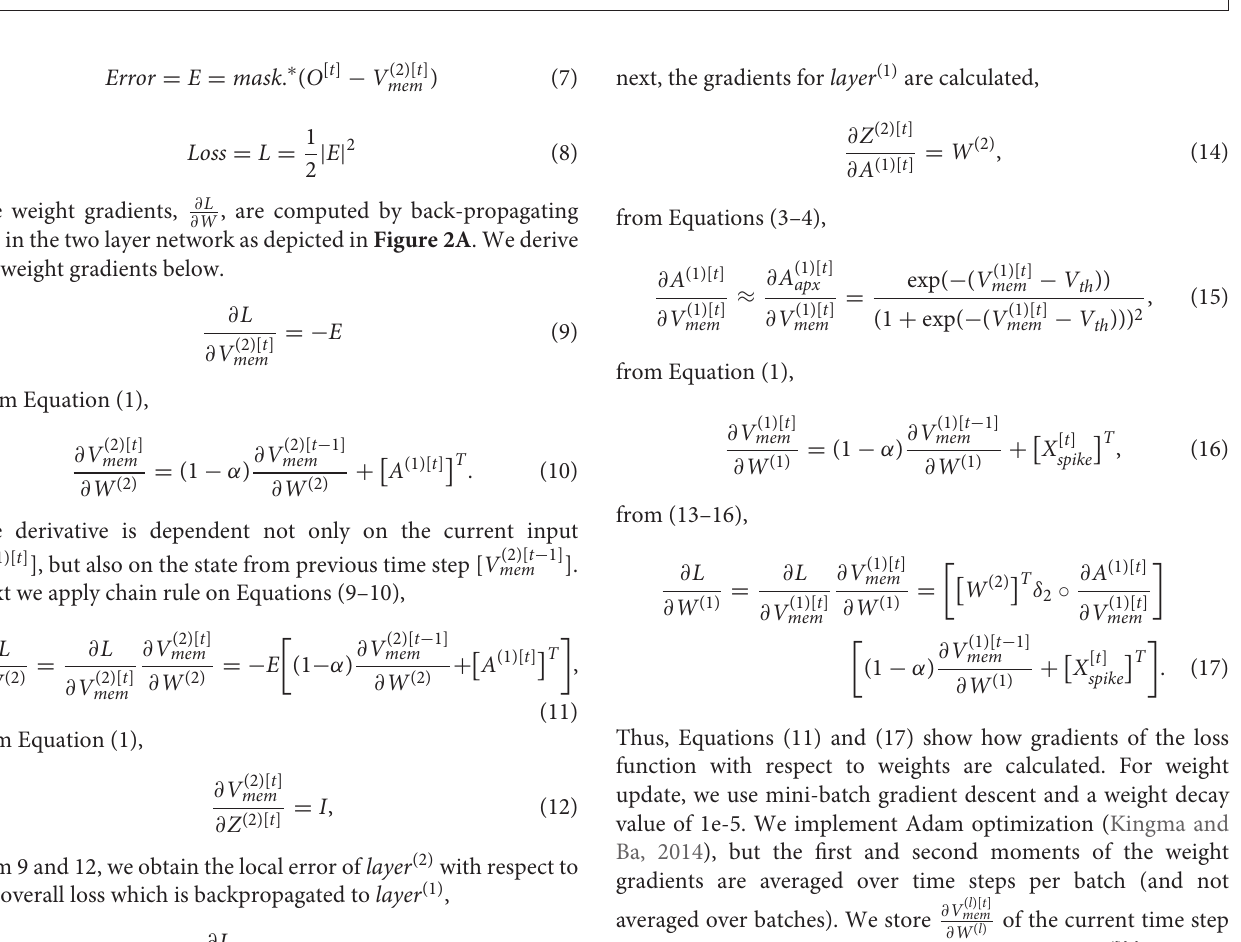
FIGURE 2 | The dynamics of a spiking neural network (SNN): (A) A two layer feed-forward SNN at any given arbitrary time instant. The input vector is mapped one-to-one to the input neurons [ layer (0) ]. The input value governs the firing rate of the neuron, i.e., number of times the neuron output is 1 in a given duration. (B) A leaky integrate and fire (LIF) neuron model with 3 synapses/weights at its input. The membrane potential of the neuron integrates over time (with leak). As soon as it crosses V th , the neuron output changes to 1, and V mem is reset to 0. For taking derivative during backpropagation, a sigmoid approximation is used for the neuron